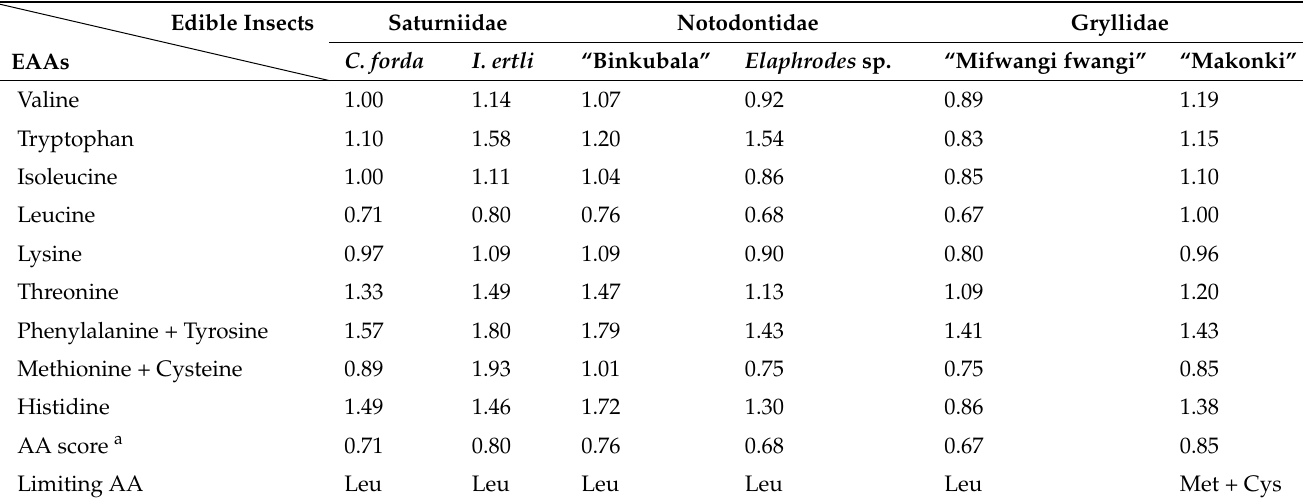
Figure 3. Graph of the first two principal components provided by correspondence analysis (CA) of the AA composition in the sampled edible insect species. Table 4. EAA ratios calculated based on the FAO/WHO pattern for preschool children (2–5 years old), estimated AA score, and limiting AA of the selected